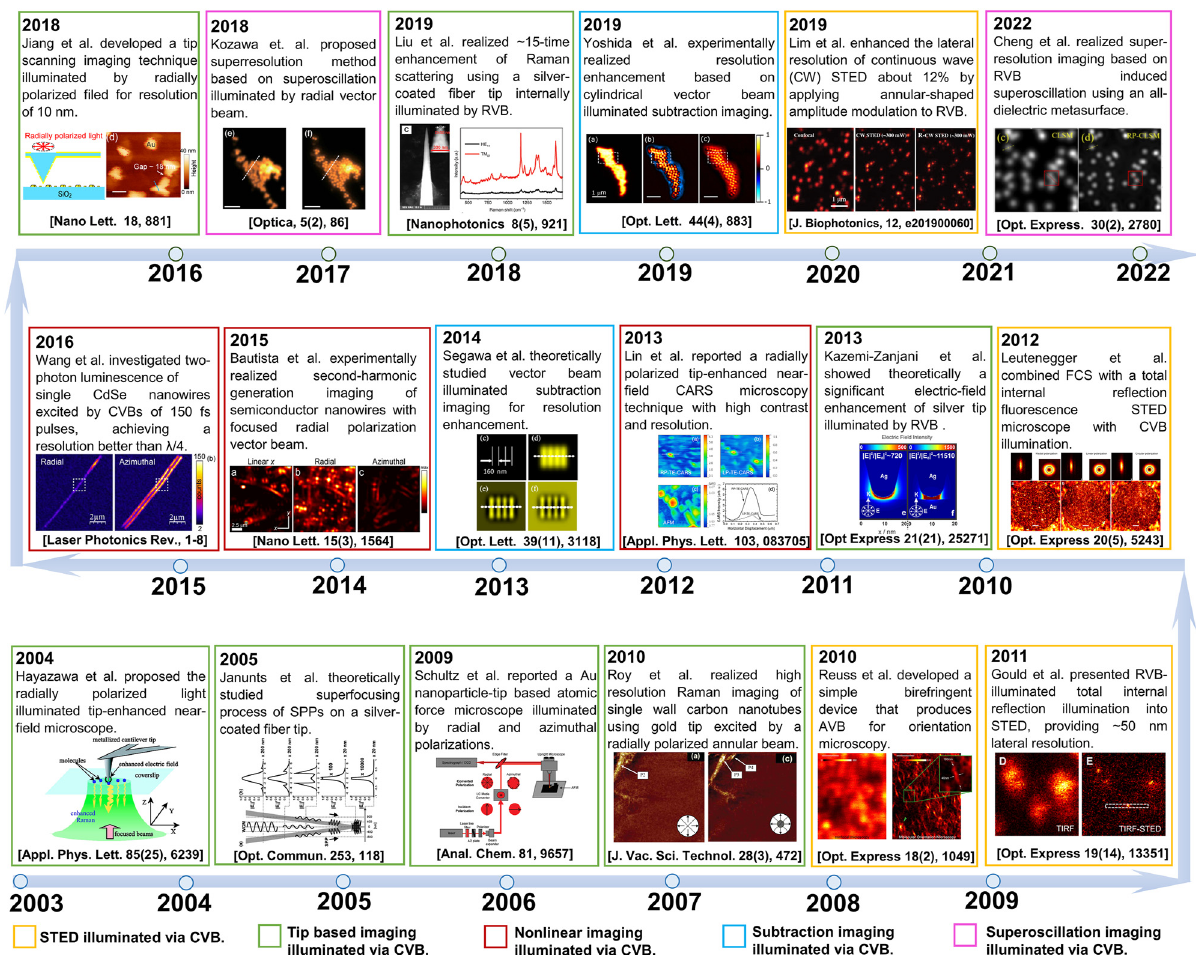
Figure 4: Roadmap of the 20-year development of CVB-based super-resolution imaging from 2003 to 2022. Adapted from Ref. [37].